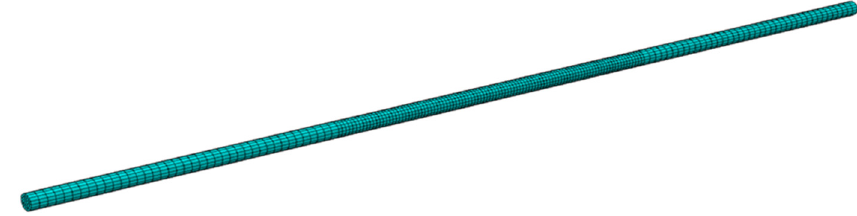
Figure 11. Fine bolt mesh.